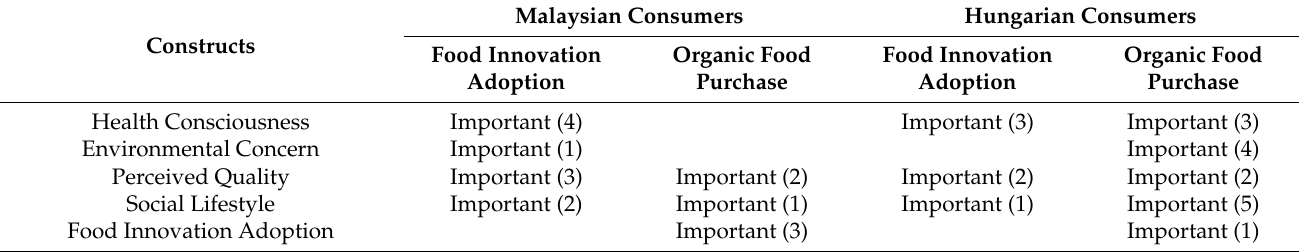
Table 7. Visual representation of Path Modelling Results showing the relative importance of the constructs.